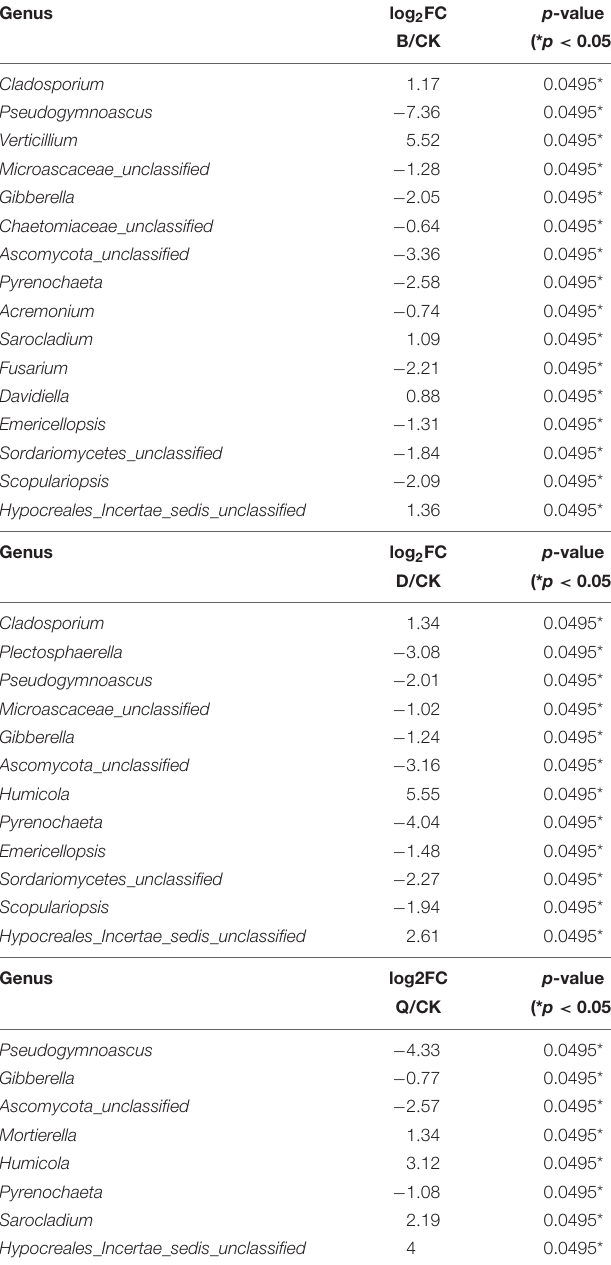
TABLE 3 | Comparison of fungal genus in different vegetable rotations and continuous tomato cropping substrates ( t